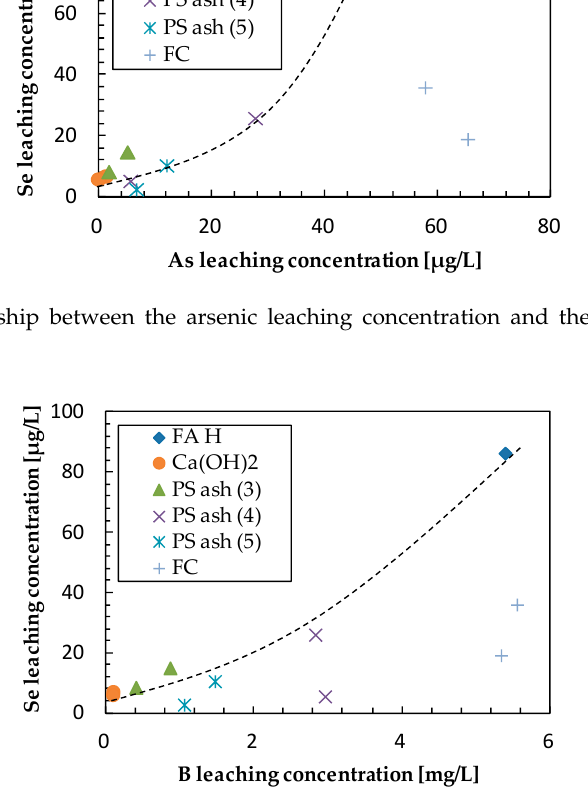
Figure 11. Relationship between the boron leaching concentration and the selenium leaching concentration.